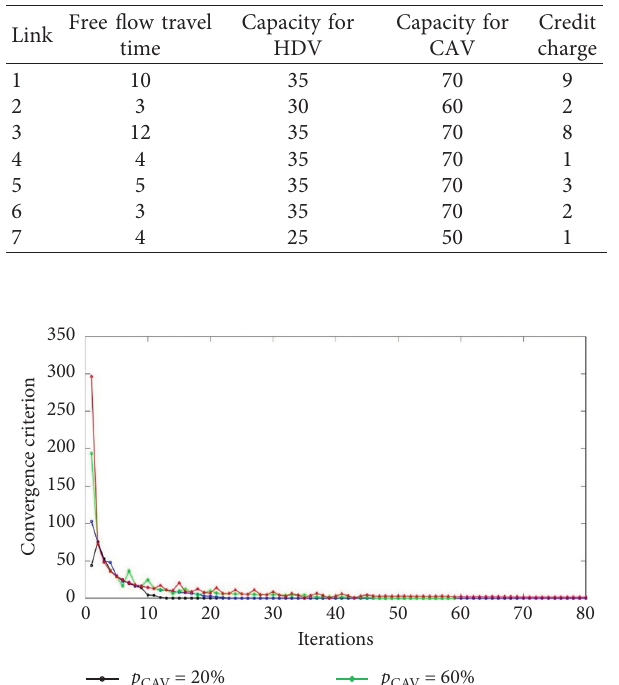
Figure 1: The small network. Table 1: Input data of the small network.